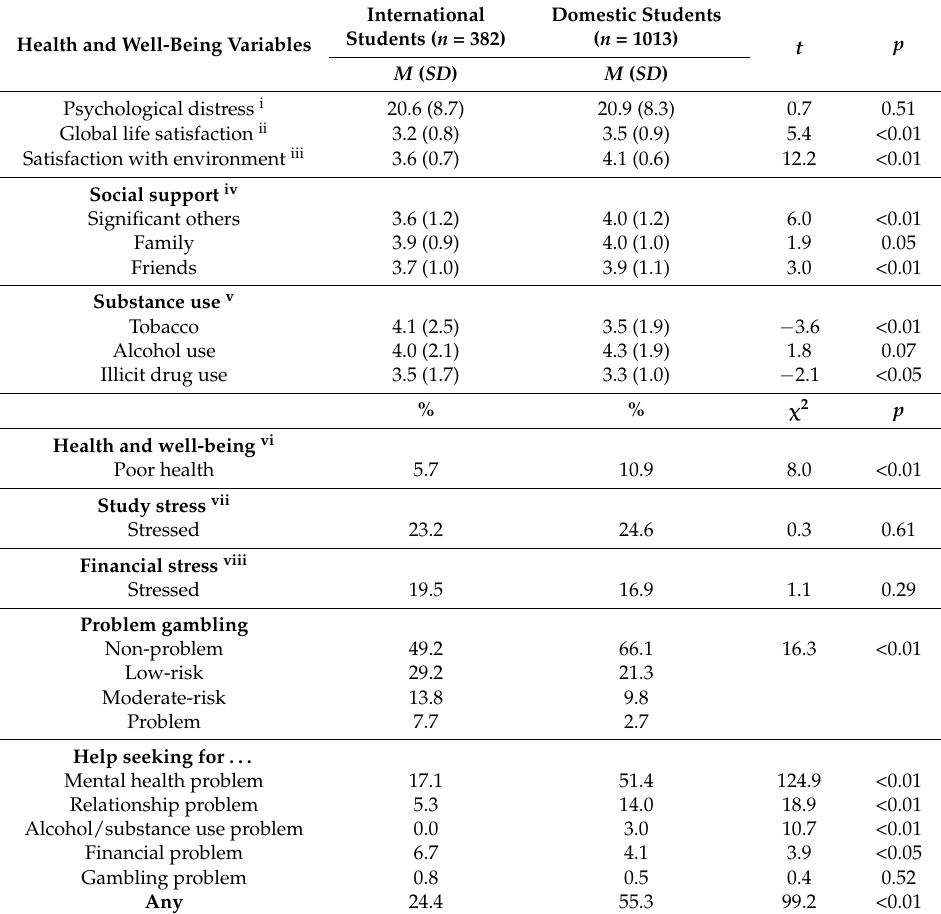
Table 2. Health and well-being by student